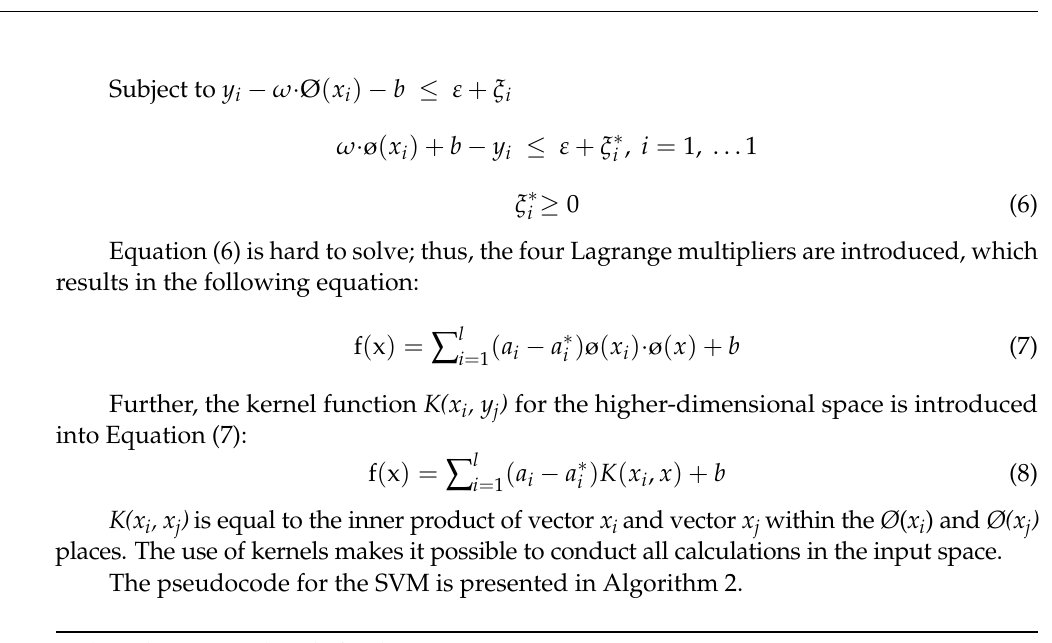
Algorithm 2. Pseudocode for the SVM